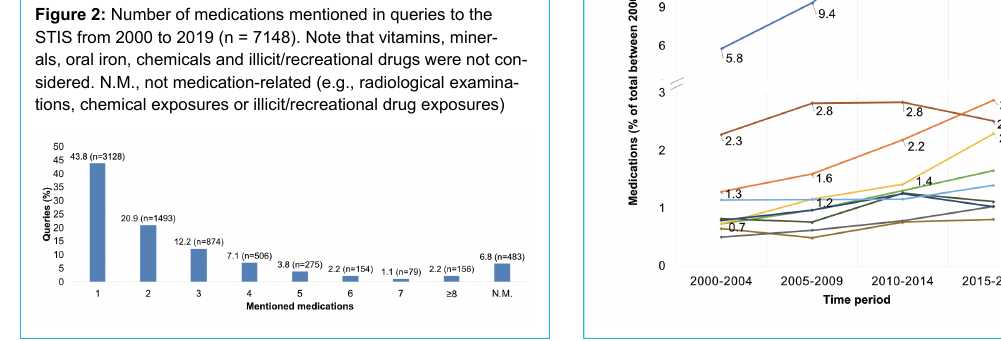
Figure 2: Number of medications mentioned in queries to the STIS from 2000 to 2019 (n = 7148). Note that vitamins, miner- als, oral iron, chemicals and illicit/recreational drugs were not con- sidered. N.M., not medication-related (e.g., radiological examina- tions, chemical exposures or illicit/recreational drug exposures)